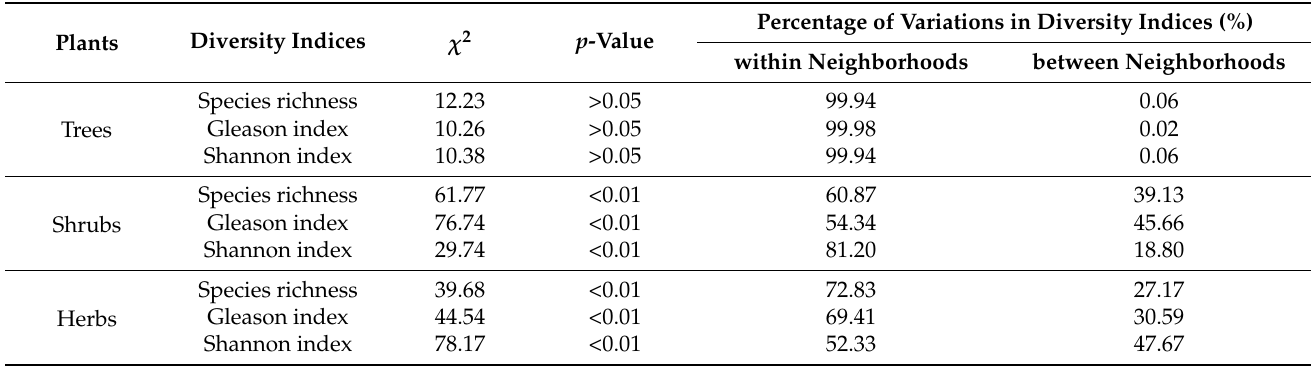
Table 3. Variance in diversity index within and between neighborhoods based on hierarchical linear modeling.